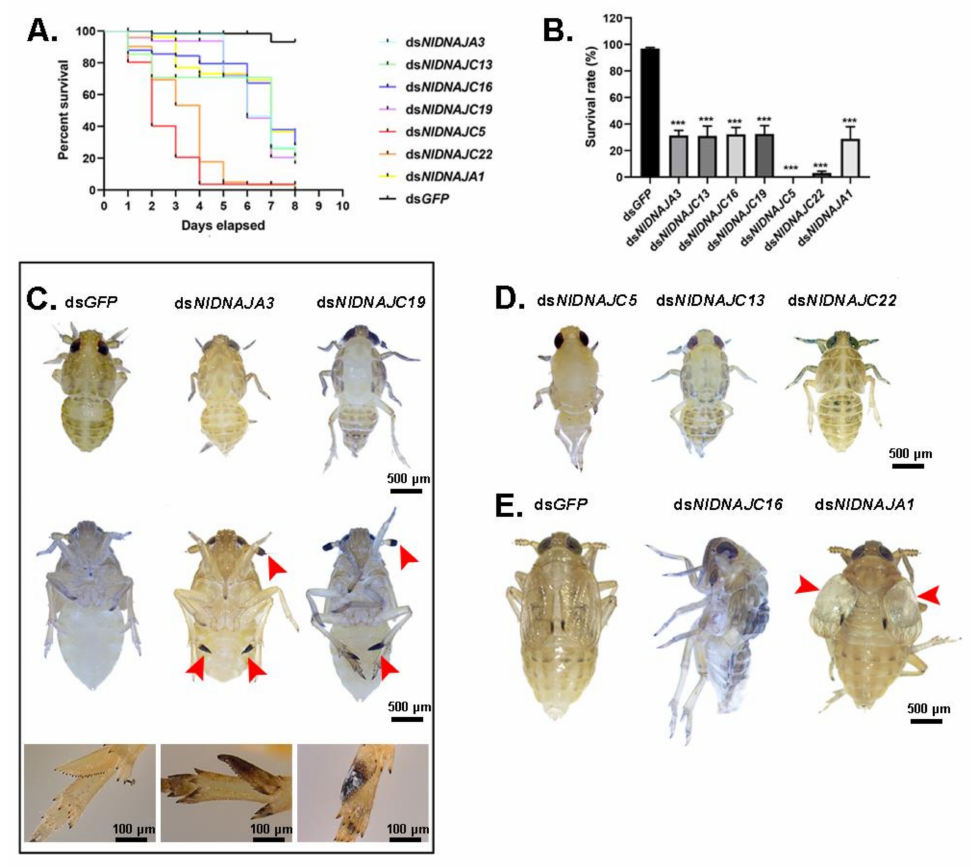
Figure 9. Effects of ds NlDNAJ s treatments on BPH. ( A ) The survival curve of BPH at 8 days after knockdown when the 3 rd instar nymphs were injected with ds NlDNAJs . ( B ) The survival rate of BPH on day 8 after knockdown. Results are presented as mean ± SEM. *** p < 0.001 (Student t -test). ( C ) Effects of ds NlDNAJA3 and ds NlDNAJC19 on the development of nymphs (Phenotype I). The burned-like black on antenna or spur is indicated by red arrow heads. ( D ) Phenotypes of nymphs after injection with ds NlDNAJC5 , ds NlDNAJC13, and ds NlDNAJC22 during ecdysis (Phenotype II). ( E ) Phenotypes of nymphs after injection with ds NlDNAJC16 and ds NlDNAJA1 during molting (Phenotype III). ds GFP was injected as a negative